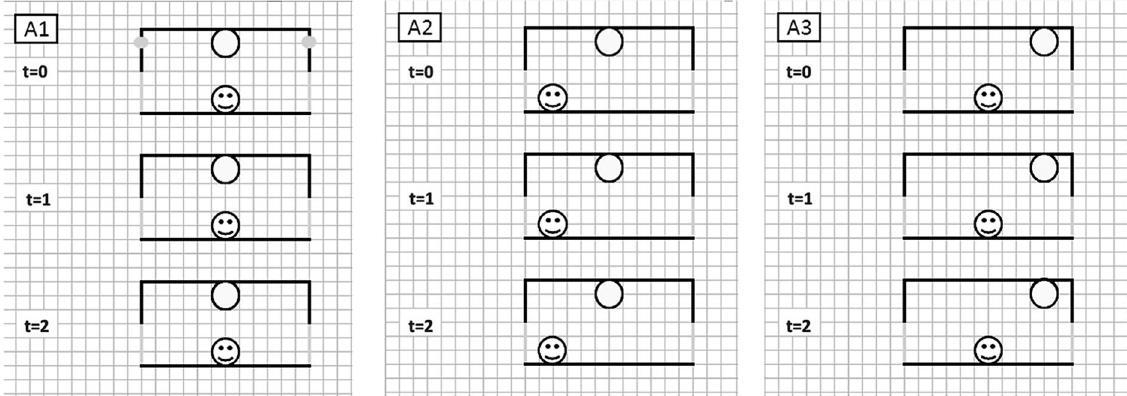
FIG. 2. Task A. EDs to probe reasoning with signal travel time and correction for signal travel time. In the diagrams, the room is depicted as a rectangle, the light source is the circle at the top, the doors are the lines at the side of the rectangle, and the observer is represented by the smiley face. To prevent an overcrowded ED, the sensors, the dots above the doors, are only shown in the first picture of task A1. Participants are instructed that the sensors are present in all the